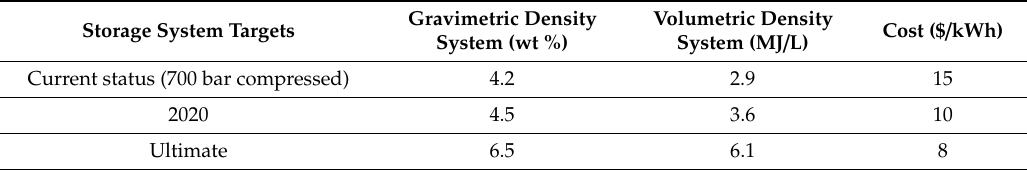
Table 2. Projected performance and cost of compressed automotive hydrogen storage systems compared to 2020 and ultimate DOE targets.